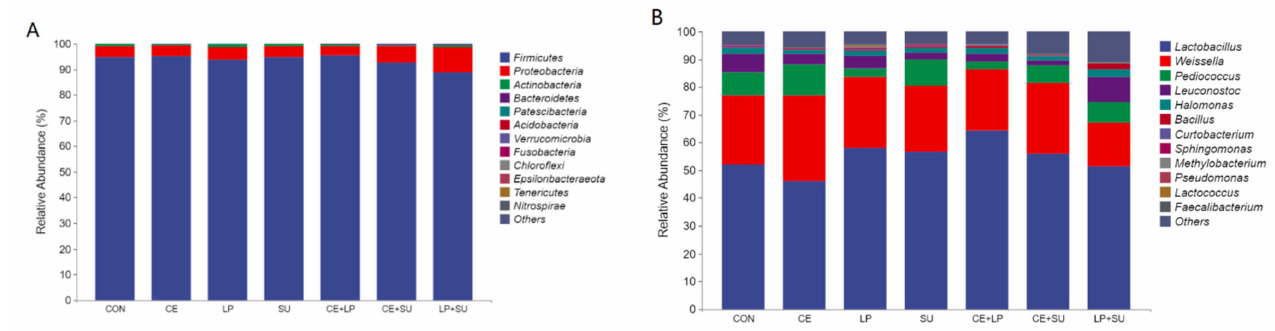
Figure 1. Principal co-ordinate analysis (PCoA) of bacterial communities for hybrid Pennisetum silage (CON, control group; CE, 100 U/g FM cellulase addition; LP, 1 × 10 6 cfu/g FM Lactobacillus plantarum addition; SU, 1% FM sucrose addition).